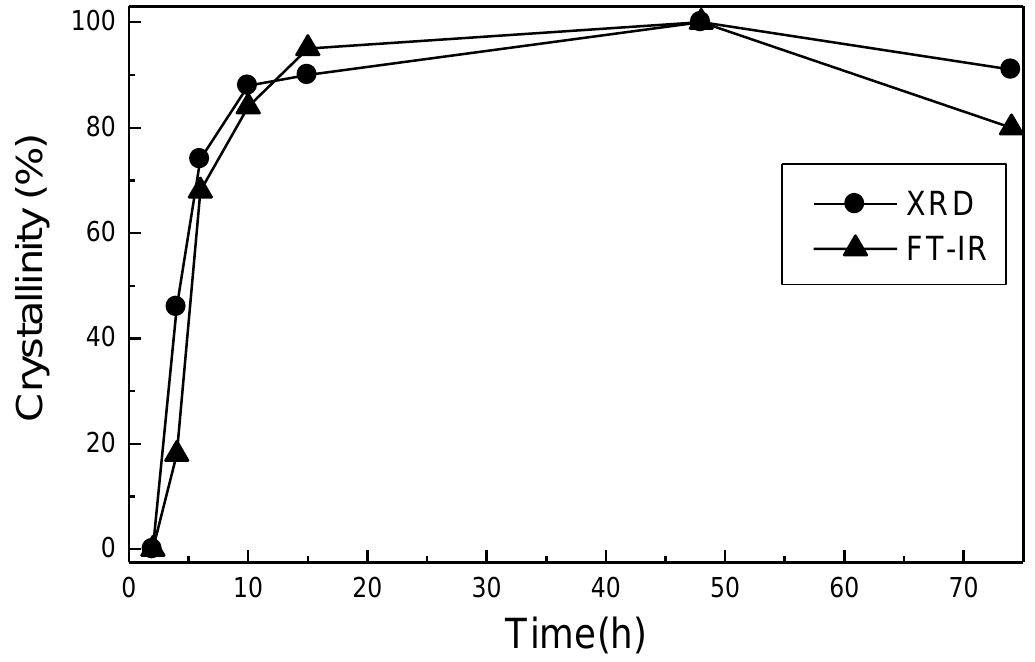
Figure 6. Curves of percentage of crystallinity versus the crystallization time obtained from XRD and FT-IR analyses. The S48h was considered as standard sample.